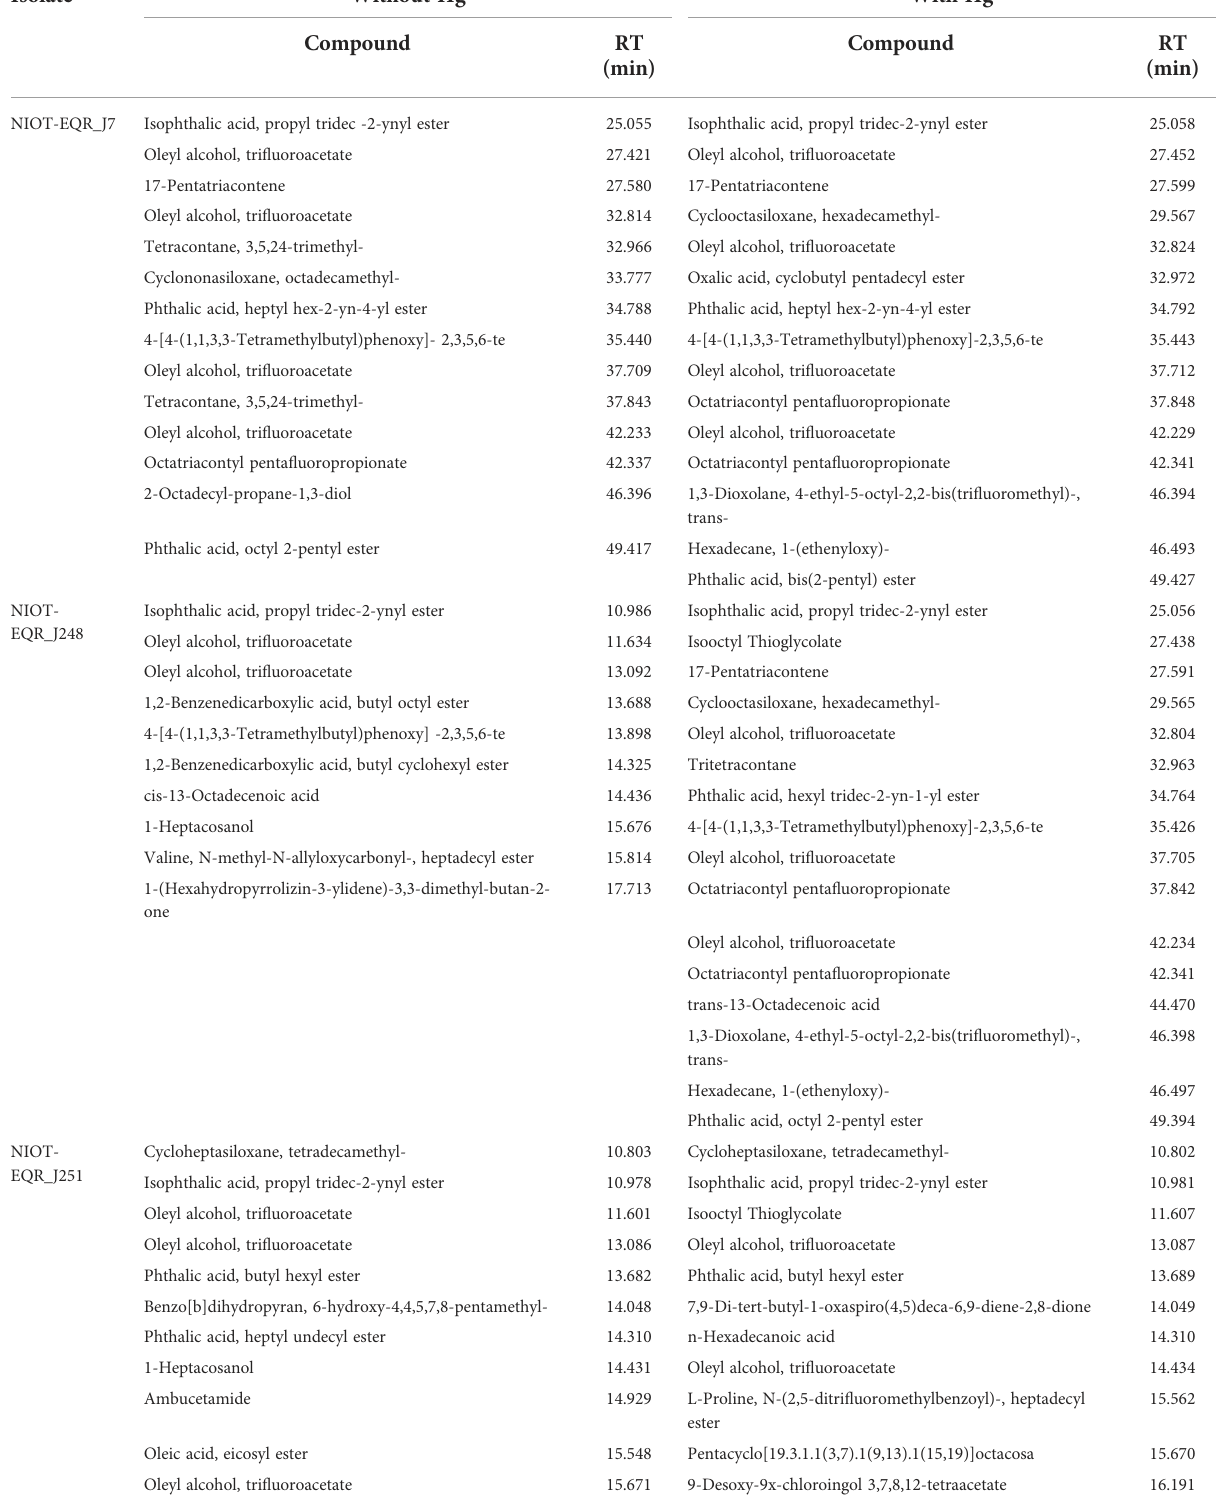
TABLE 1 Biochemical compounds identi fi ed in ethyl acetate and chloroform (1:1; v/v) extract of isolates in the absence and presence of 50 mg/L Hg as HgCl 2 by